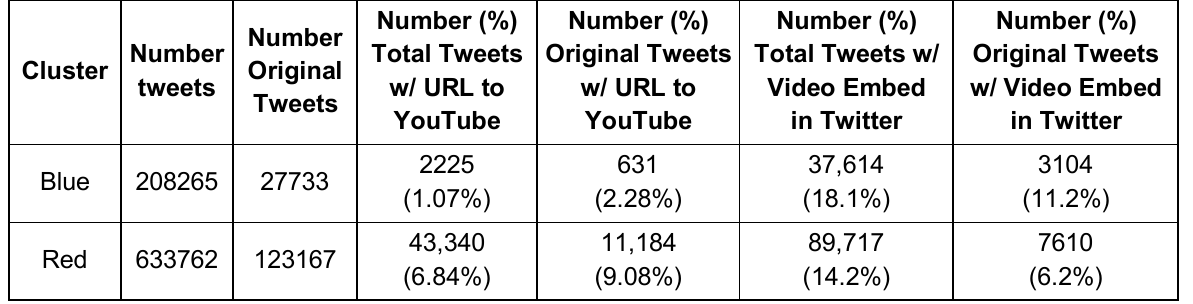
Table 2. The number of tweets that contain embedded videos or YouTube